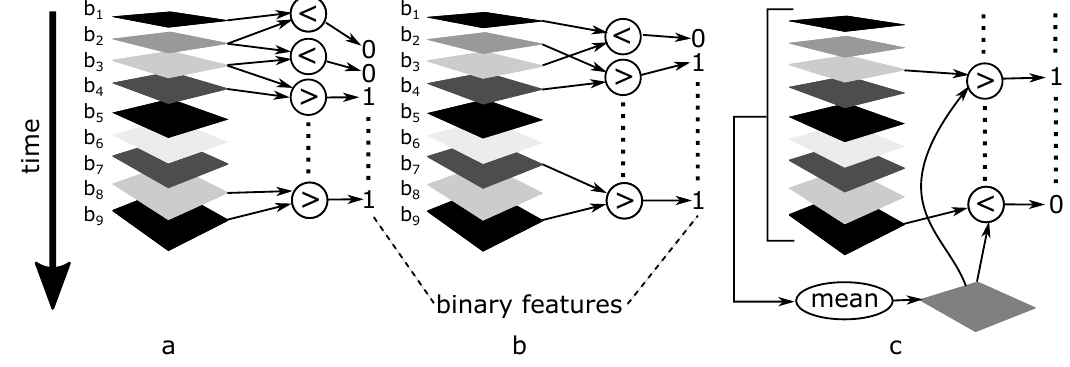
Figure 2. Creation of binary features from a pixel’s sequence of brightness values. ( a ) Comparison of temporally adjacent brightness values. ( b ) Comparison of each brightness value with every second brightness value. ( c ) Comparison of each brightness value with the mean brightness of the pixel (BICOS and